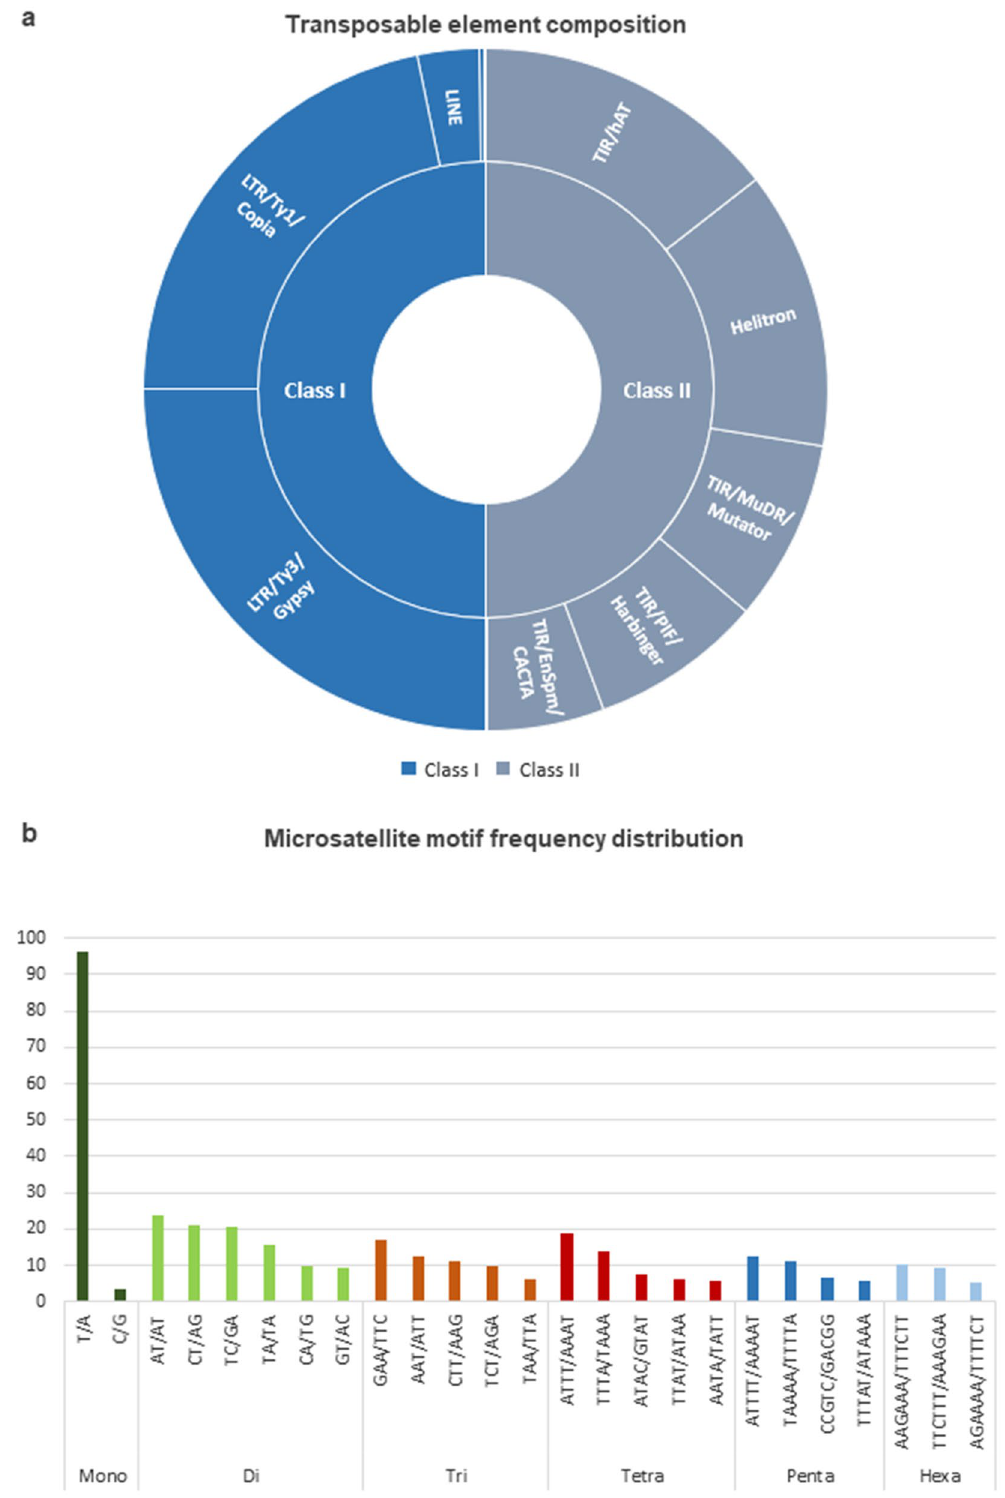
Figure 4. Repetitive DNA composition in the C. oblonga genome assembly. ( a ) Transposable element (TE) families are displayed in the doughnut chart according to their relative abundances in the assigned classes (Class I/II). Class I and Class II are not scaled to their relative occurrences in the C. oblonga genome, the abundances of TE families adding up to 100% for each class (Class I/II). TE families constituting less than 1% of either class is not displayed in the chart. ( b ) Microsatellite motif distribution is presented with respect to motif length. x-axis displays motifs that constitute more than 5% of the relevant motif type. y-axis displays percentage abundance of each